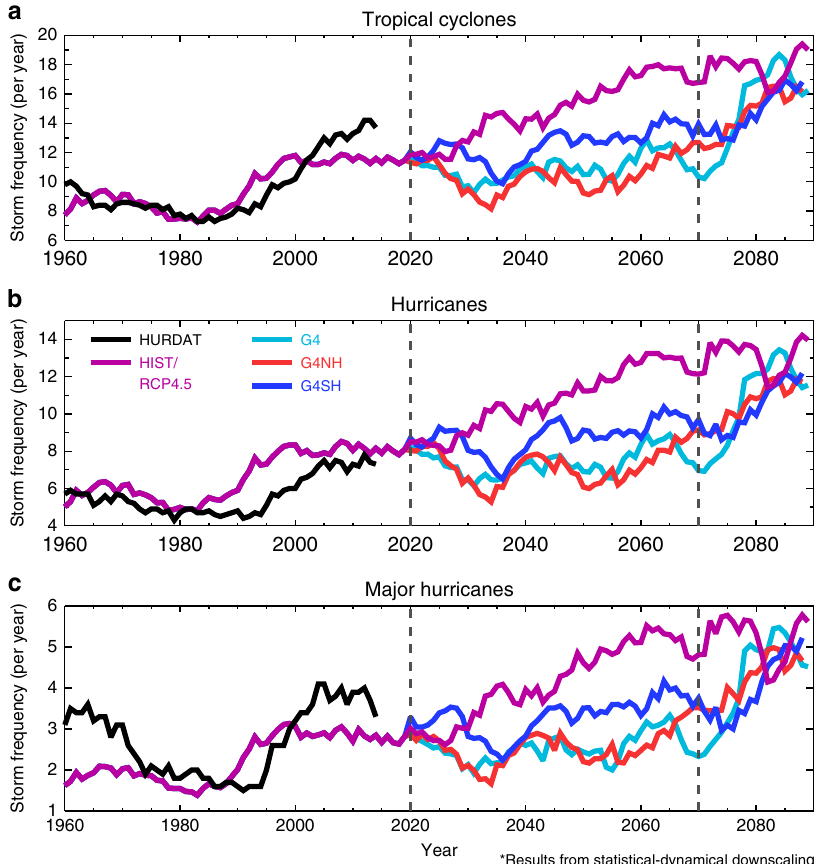
Fig. 9 Tropical cyclone frequency from downscaling simulations. a North Atlantic tropical cyclone (max windspeed > 20 m s − 1 ) frequency from downscaling simulations using HadGEM2-ES simulated meteorology plotted with observed (HURDAT) TC frequencies. All smoothed with 10-year simple moving averages. b The same as a but for hurricane (max windspeed > 37 m s − 1 ) frequency. c The same as a and b but for major hurricane (max windspeed > 96 m s − 1 ) frequency. G4 refers to a global SAI scenario, G4NH refers to a northern hemisphere SAI scenario and G4SH refers to a southern hemisphere SAI scenario. Vertical dashed lines at years 2020 and 2070 indicate the start and cessation of solar geoengineering,